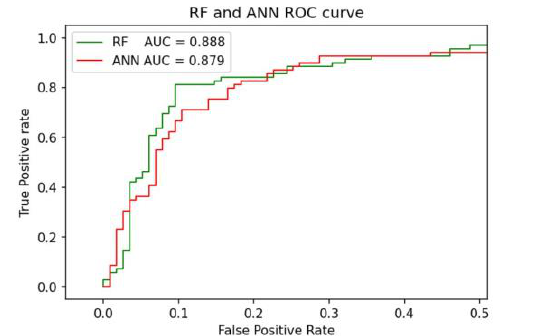
Figure 8. ROC curves obtained for the RF and for the ANN.